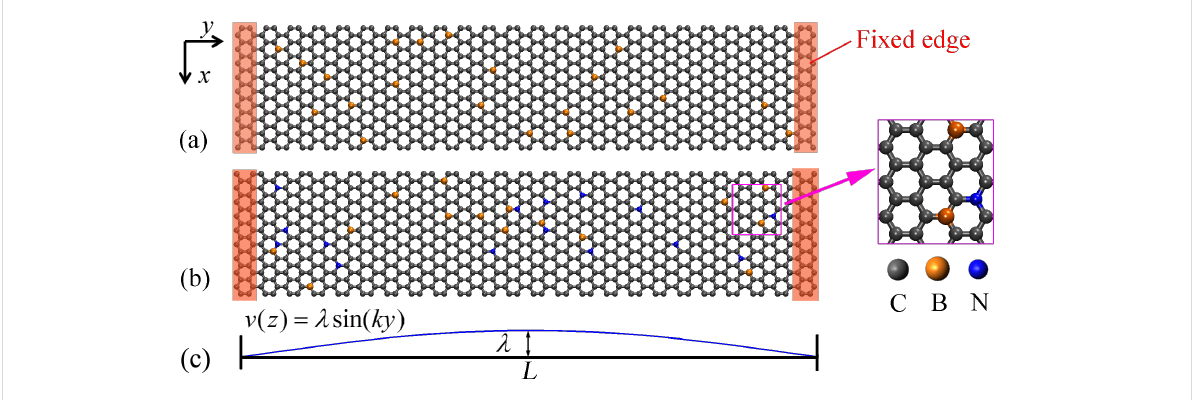
Figure 1: (a) A perfect GNR with 3% B-dopant. (b) A perfect GNR with 1.5% B- and 1.5% N-dopant. (c) Velocity excitation profile. The regions high- lighted in red in (a) and (b) represent the fixed edges.